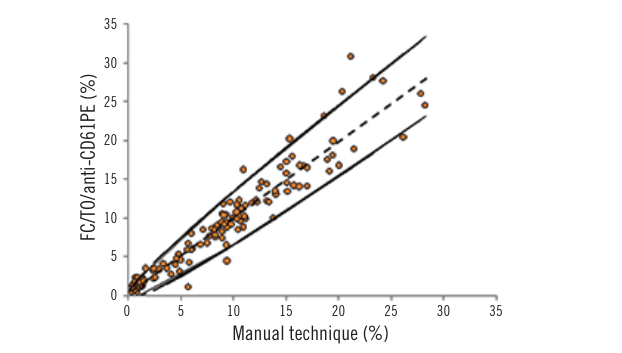
figurE 3 − Reticulocyte count (%) by the manual method and by FC/TO, excluding CD61-positive cells ( n = 150) Continuous lines: 95% binomial confidence interval; traced line: linear regression between the evaluated methods; Y = 0.297 + 0.983X; r 2 = 0.93; r = 0.964. FC/TO: method of reticulocyte count by flow cytometry, using thiazole orange.